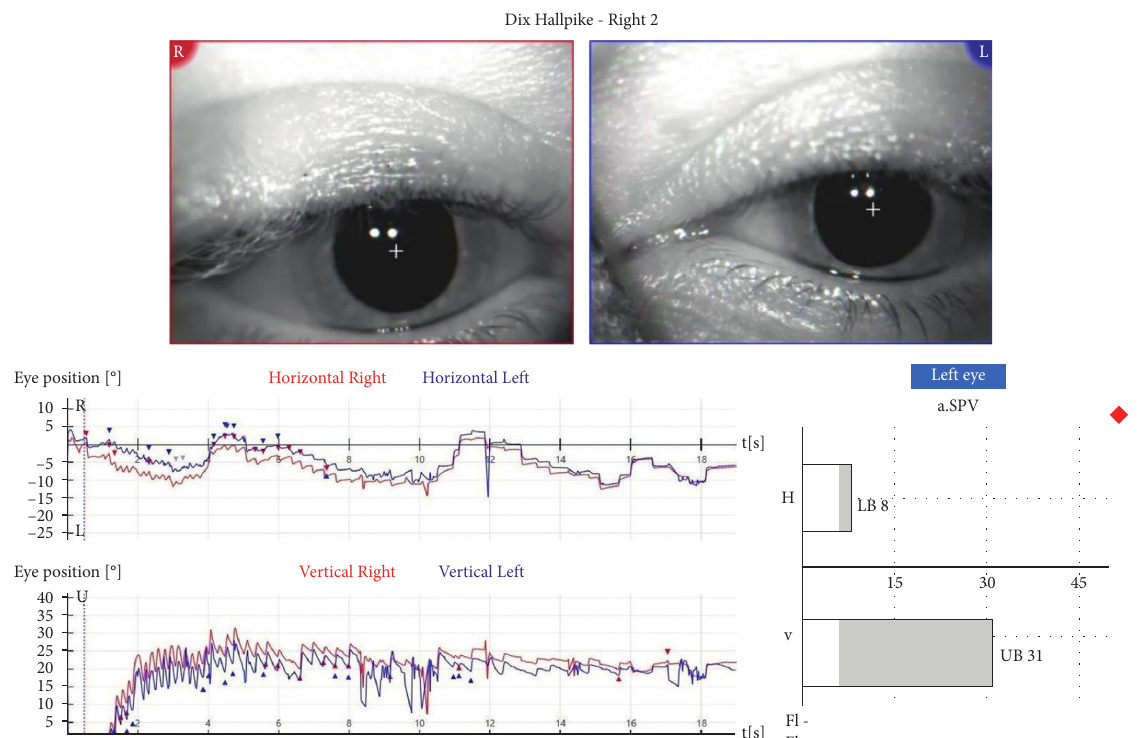
Figure 3: Right-sided Dix–Hallpike test performed during the follow-up exam a week after the initial VNG recorded geotropic vertical- rotatory PN lasting for 10 seconds with the upbeat directed vertical component of SPV 31 ° /sec and a torsion geotropic directed component of SPV 8 °